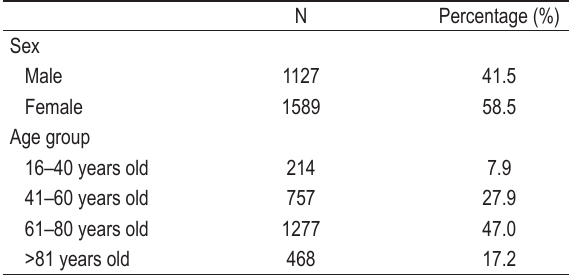
TABLE 1. Characteristics of the study